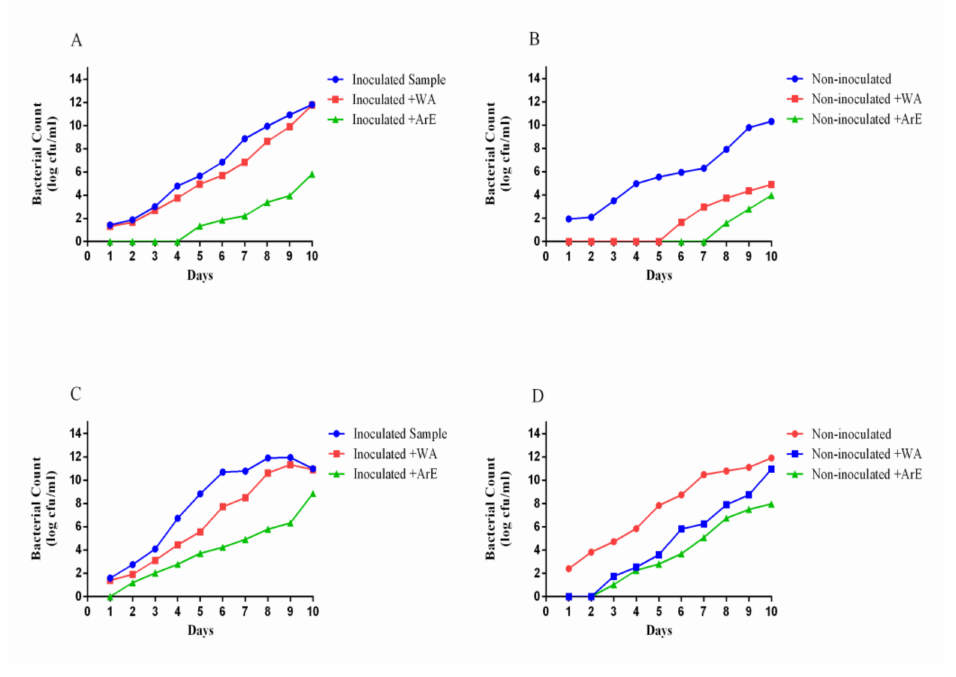
Figure 5. The effect of the mixture (ginger:thyme:coriander) extract types at two storage tempera- tures, the safety properties of inoculated ( B. cereus ) and non-inoculated samples of ready-to-eat rice. ( A ): effect of aromatic (ArE) and water (W.A.) extracts against inoculated B. cereus growth at refriger- ation condition of ready-to-eat rice; ( B ): effect of aromatic (ArE) and water (W.A.) extracts against normal bacterial contamination at refrigeration condition of ready-to-eat rice; ( C ): effect of aromatic (ArE) and water (W.A.) extracts against inoculated B. cereus growth at a room temperature storage; ( D ): effect of aromatic (ArE) and water (W.A.) extracts against normal bacterial contamination at room temperature storage. The results were expressed in CFU/g for the rice examined samples, the aromatic extract was applied in the nano-form of chitosan